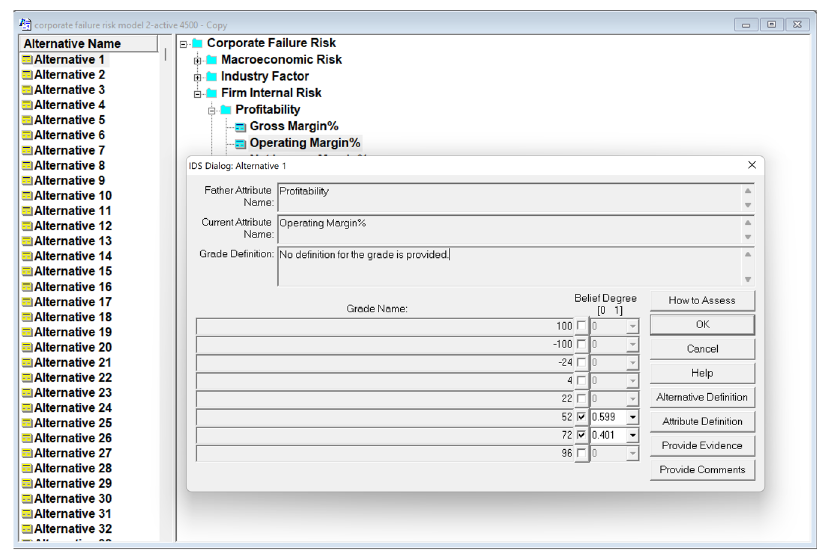
Figure 5. Collecting data for alternatives.